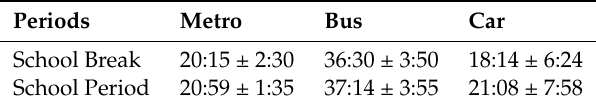
Table 4. Average commuting times and SDs in MM:SS (N =